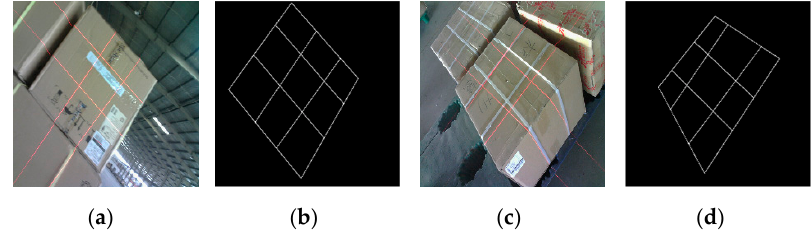
Figure 9. Architecture of the proposed improved holistically nested edge detection (IHED) network.